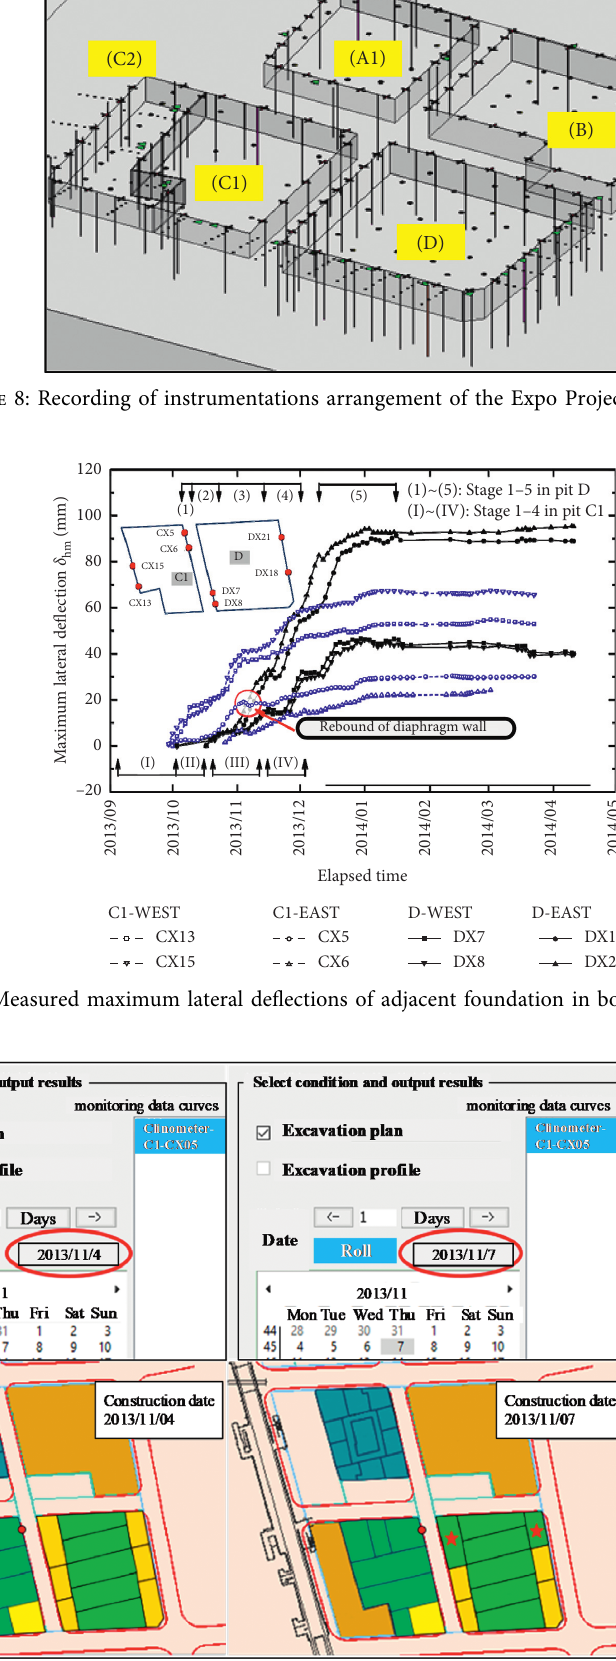
Figure 10: Synchronous changes of the excavation stage and the wall deflection